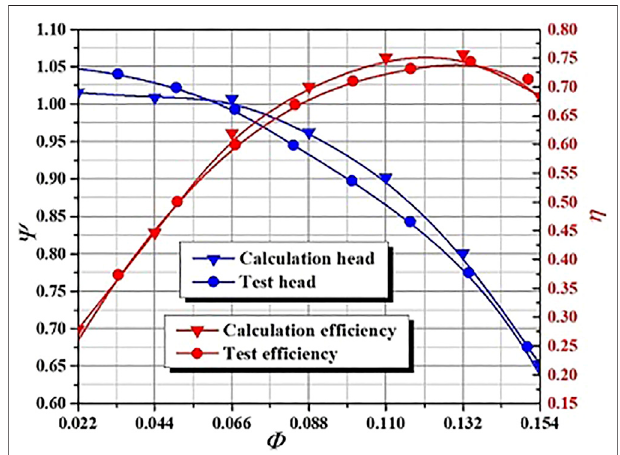
FIGURE 3 | Investigation of the calculation and experiment.